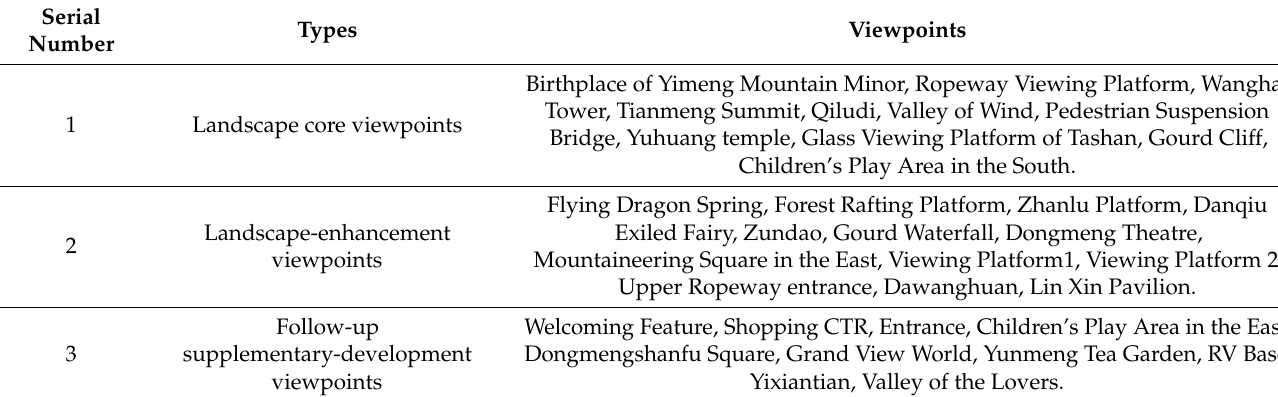
Table 8. The functional division of